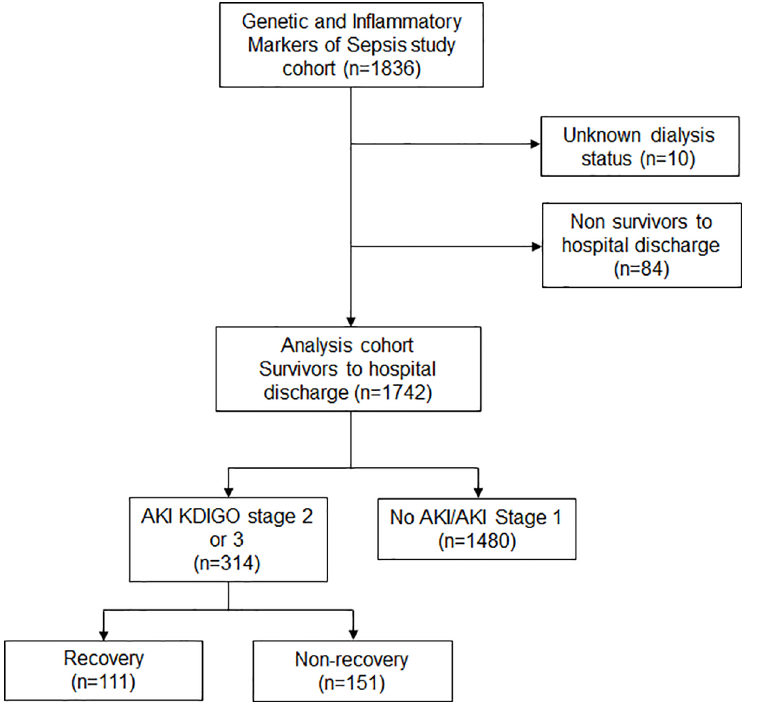
Fig 1. Flow chart of study